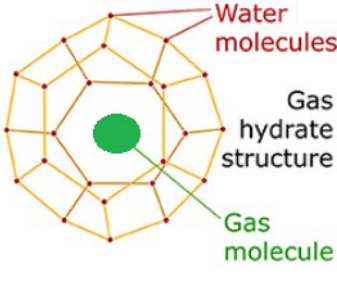
Figure 1. Gas hydrate model